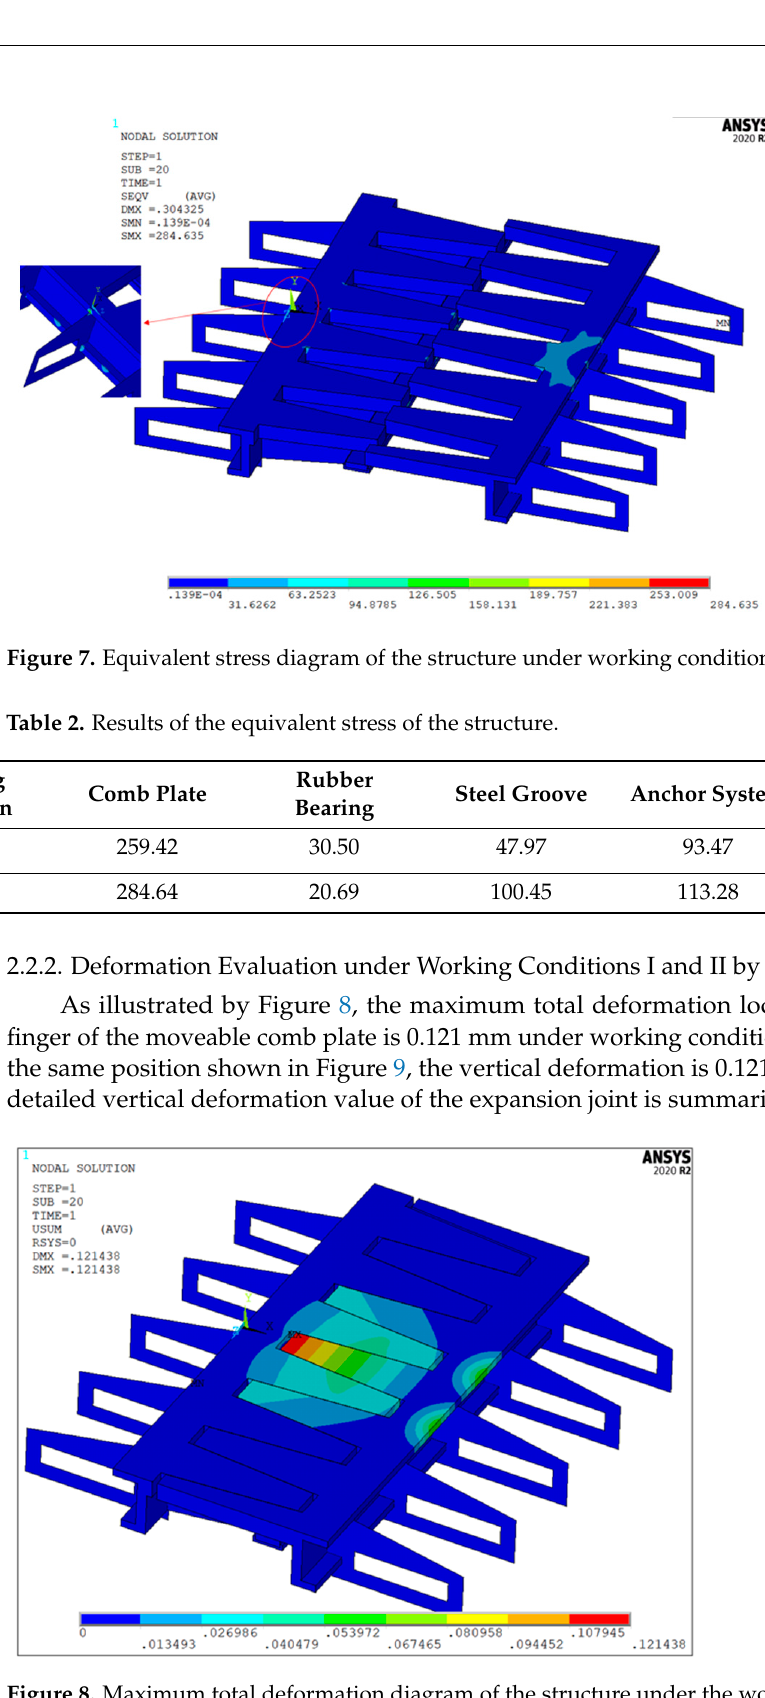
Figure 6. Equivalent stress diagram of the structure under working condition I.